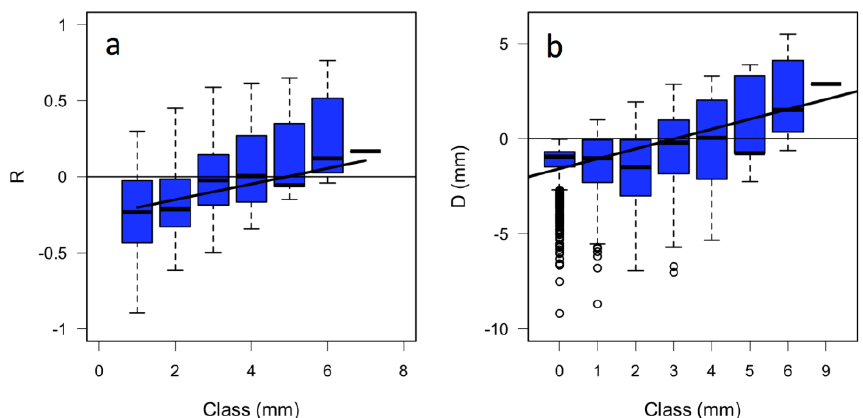
Fig. 1. (a) Boxplots of newly calculated ratio R and (b) difference D for forecasted and observed precipitation amounts per precipitation Figure 1: a) Boxplots of newly calculated ratio R and b) difference D for forecasted 36 class. Solid line shows a linear regression through the median value of each class. and observed precipitation amounts per precipitation class. Solid line shows a linear 37 regression through the median value of each class. 38